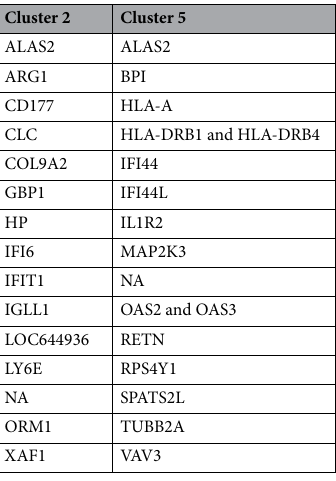
Table 4. Genes present within clusters 2 and 5 of the type 1 interferon/ black carbon 0–6 day lag